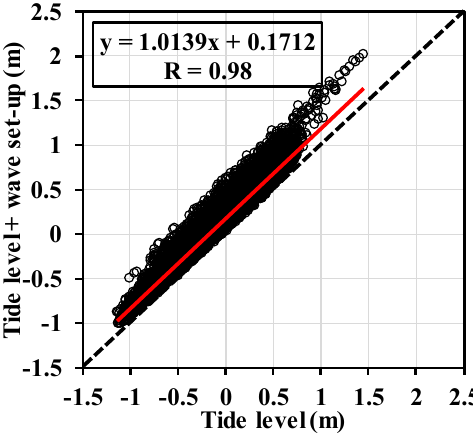
Figure 16. The scatter plot of the tide level and tide level + wave set-up (2005–2008). The red line represents the linear fitting line.